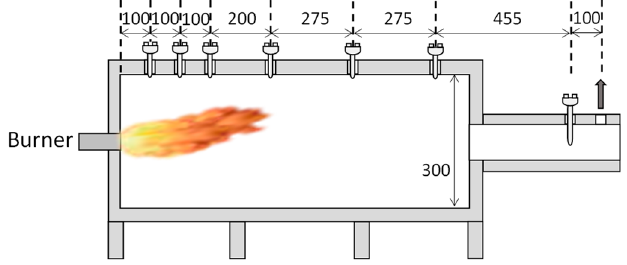
Figure 1. 10 kW test furnace.